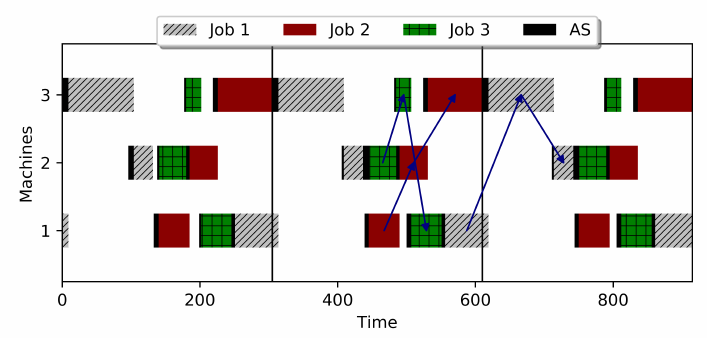
Figure 7. The Gantt chart of three consecutive cycles for the considered instance problem; blocking CJSS problem with sequence-dependent anticipatory setups (AS).